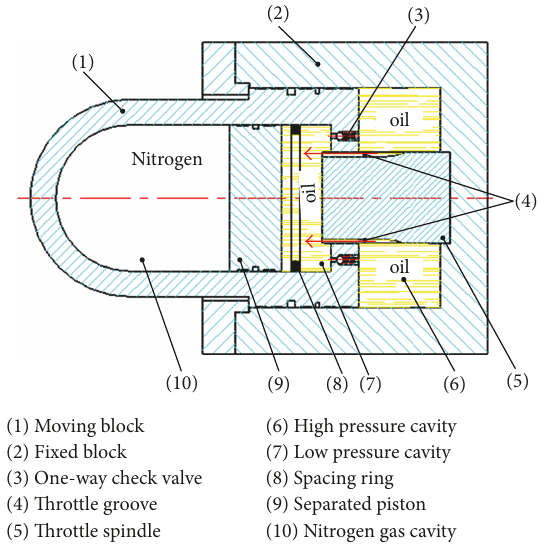
Figure 4: Structure stretch of the high-power hydraulic shock wave